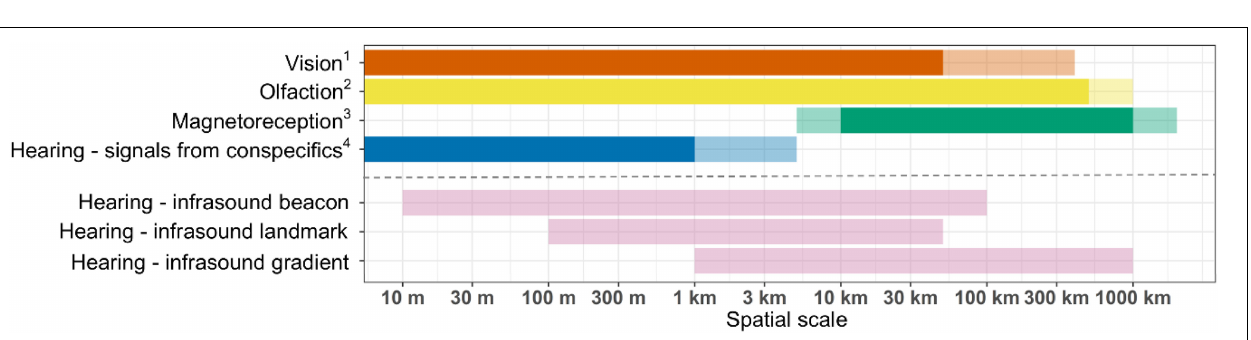
FIGURE 4 | A navigation framework for infrasound. We propose three non-exclusive scenarios for the use of infrasound for navigation by birds as (A) beacons, (B) landmarks, and (C) gradients. We consider a hypothetical bird trajectory (in black) sampled at locations x 1 , x 2 and the target at times 1, 2, and 3. In each panel, blue elements indicate the relevant information used by the bird. (A) In the beacon hypothesis, the target location, e.g., the bird’s colony is the infrasound source that the bird detects and moves toward. This hypothesis requires the bird either to perceive directly the direction of the beacon, shown here by the blue arrows and optimise its path toward it (taxis), or at least to detect whether it is approaching or moving away the target. In this case, the bird could rely only on variations of field intensities (differential klinokinesis) without the need to sense the gradient direction. (B) α , β , and γ are three infrasound sources (e.g., islands). The combination of their infrasound signals in space provide a unique acoustic landmark in the form of an infrasound signature at the target (power spectrum in blue, I is the sound intensity and f the frequency); power spectra at x 1 and x 2 are compared to the power spectra at x 1 to reassess location. (C) Large-scale infrasonic amplitude gradient fields can provide a functional coordinate reference system. We illustrate this scenario with two gradient fields from two different sources (gradient isolines are represented by grey parallel lines, with directions orthogonal to the gradient directions, and widths proportional to the signal intensities). The bird could use the gradient fields as a coordinate system, guiding it to navigate toward its desired target characterised by specific intensities (blue arrows).